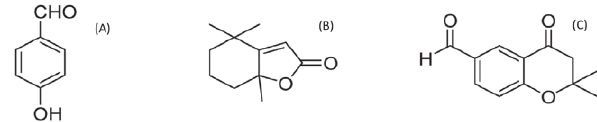
Figure 7. Phytotoxins produced by Fomitiporia mediterranea , based on relevant reports. ( A ), 4-Hydroxybenzaldehyde; ( B ), dihydroac- tinolide; ( C ), 6-Formyl-2,2-dimethyl-4-chromanone. Chemical for- mulae retrieved by PubChem